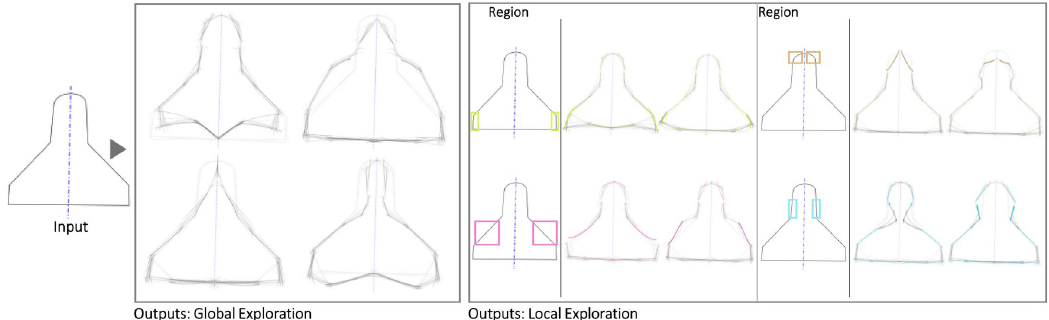
Fig 13. Some of the Global and Local shape variations generated with Shapi for the conceptual exploration of a lamp shade. The Seed is based on an exploration by an industrial designer [92].